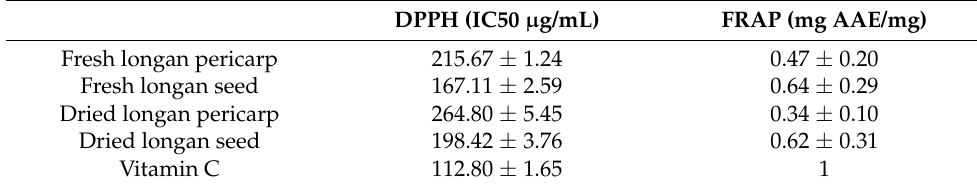
Table 2. Antioxidant activities of longan ECTs.